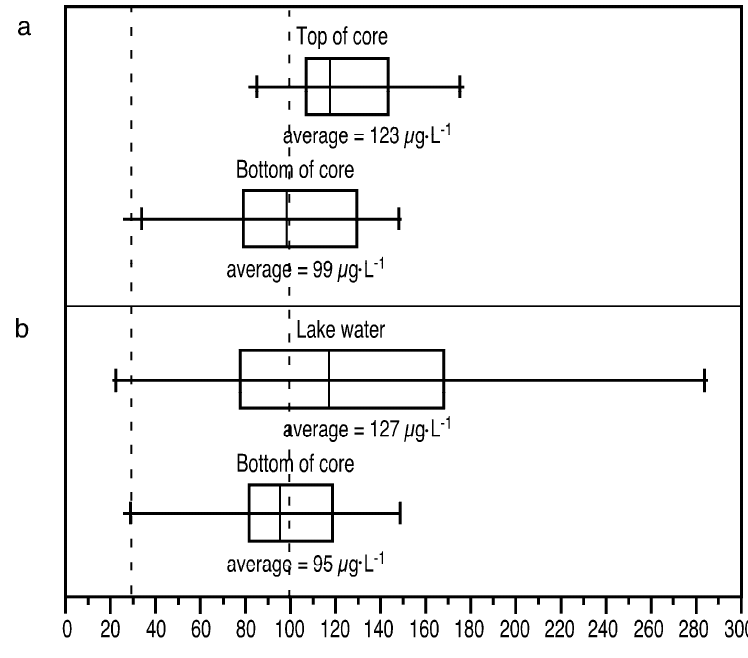
Figure 6. ( a ) Box plots (minimum, 5%, 25%, median, 75%, 95%, maximum) of diatom-inferred total phosphorus concentrations at the tops and bottoms of sediment cores from 33 Iowa lakes as reported by Heathcote et al. [9]. ( b ) Box plots for 22 lakes with diatom-inferred concentrations of total phosphorus at the bottoms of cores and average measured concentrations of total phosphorus in the lake waters for 2000–2010. Left dashed line shows the boundary between mesotrophic and eutrophic lakes (30 µg·L − 1 ) and the right dashed line shows the boundary between eutrophic and hypereutrophic lakes. (100 µg·L − 1 ).